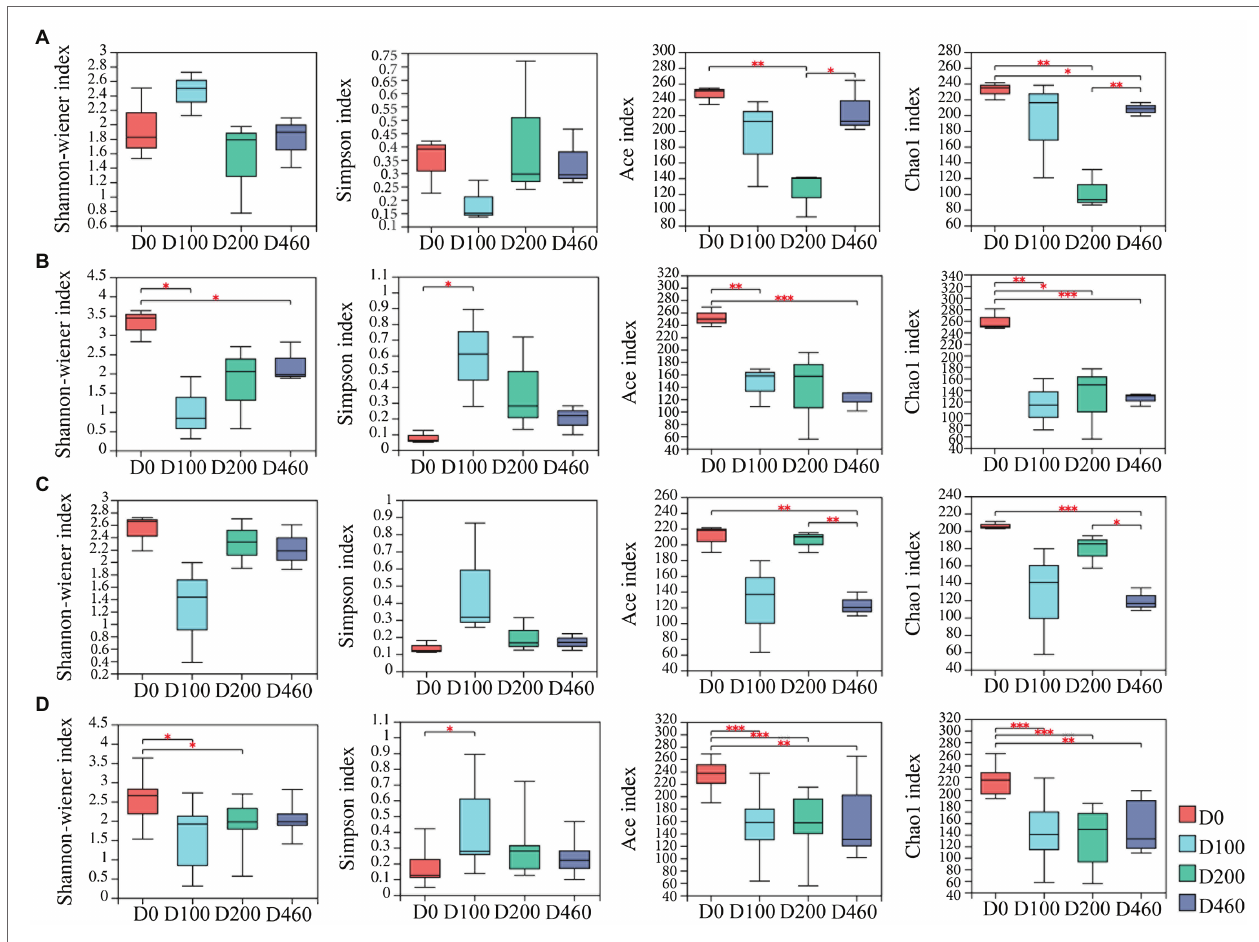
FIGURE 1 | The dynamics of litter fungal community diversity indexes in S516 (A) , S536 (B) , S560 (C) , and the whole copper mining area (D) . Significance levels were denoted with ** p < 0.01 and *** p < 0.001.